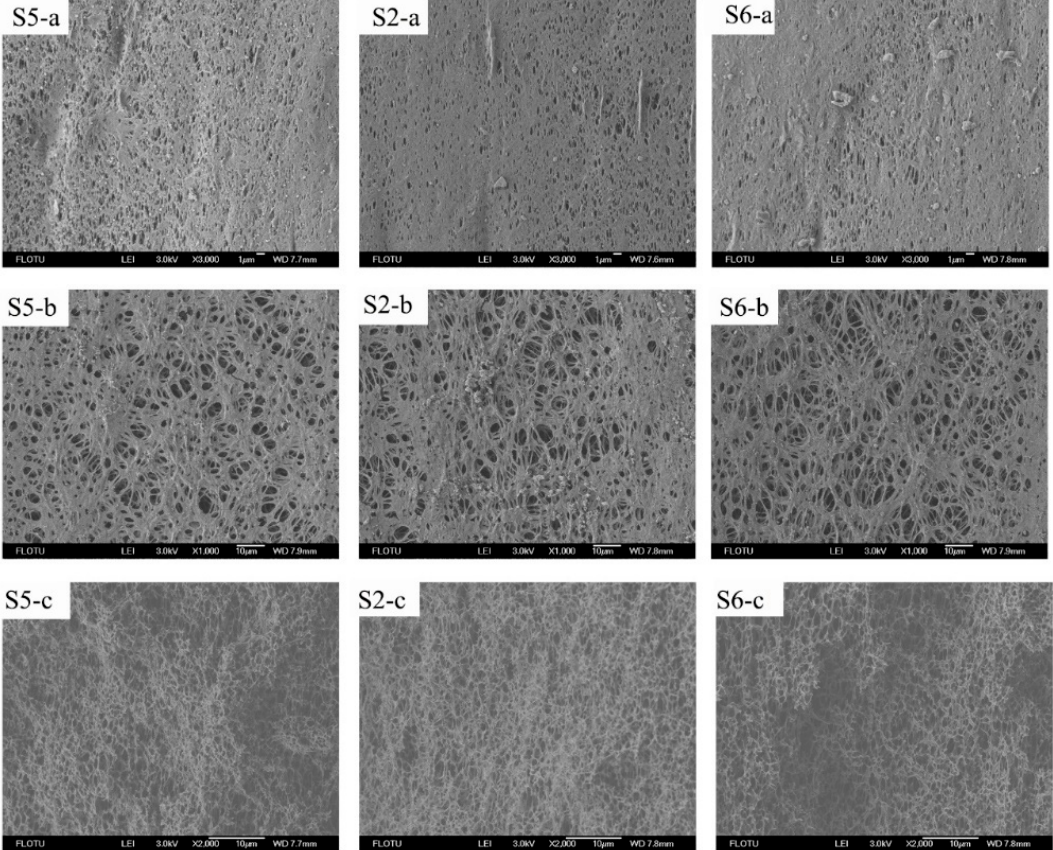
Figure 8. The SEM photos of the outer, inner surface, and the cross-section (along the stretching direction) of the membrane samples stretched with different stretching rates. In the figure, a , b and c represent the outer surface, the inner surface, and the cross-section (along the stretching direction) of the hollow fiber membrane samples, respectively.